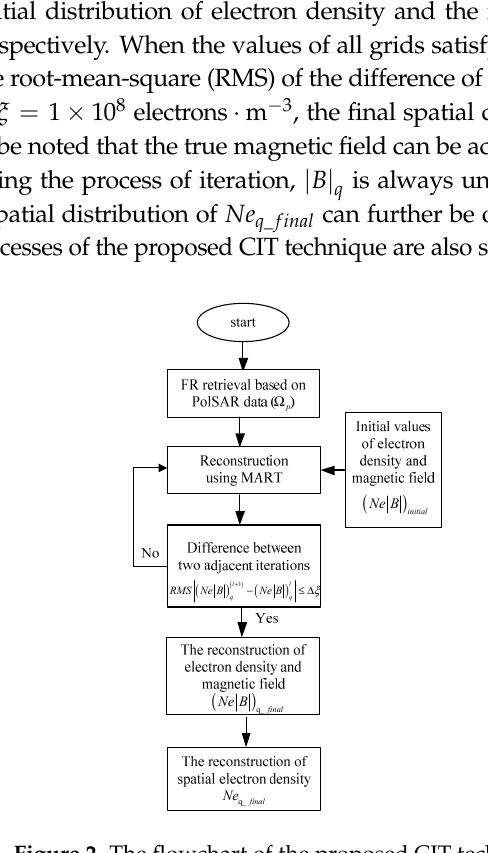
Figure 2. The flowchart of the proposed CIT technique.